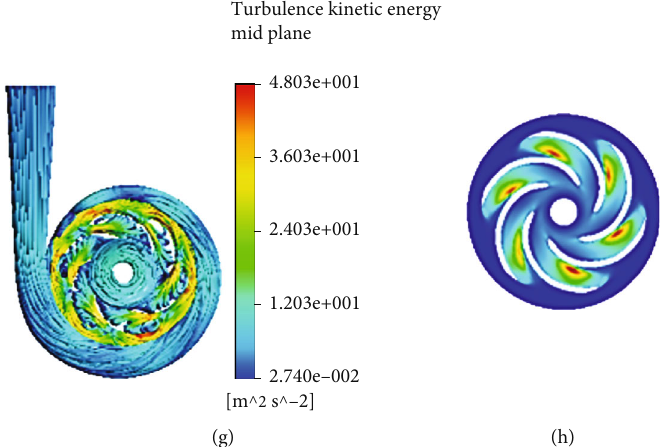
Figure 15: The e ff ect of blade grooving on the internal fl ow characteristics of the